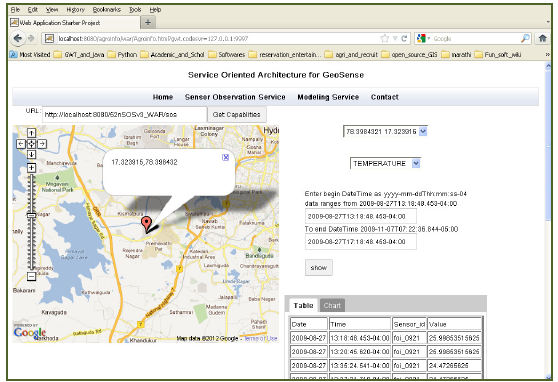
Figure 6. Sensor Observation Service